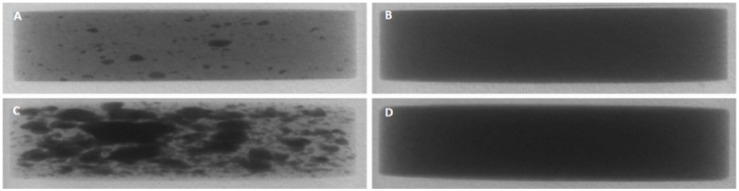
Transverse view of XμCT reconstruction of placebo tablets (13mm) containing contrast material in the core.Contrast material Bi2O3 is included at 5% w/w and 10% w/w (milled), A and B respectively. BaSO4 is included at 10% w/w and 20% w/w (milled), C and D respectively.